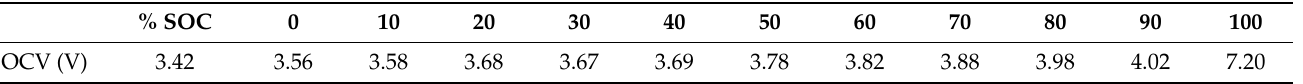
Table 1. OCV measured